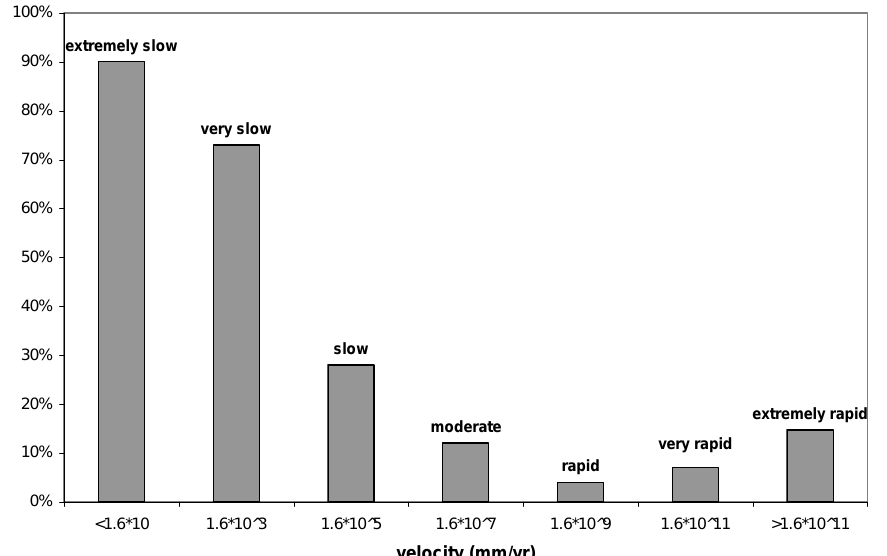
Figure 5. Landslides with at least 1 PS vs. landslide